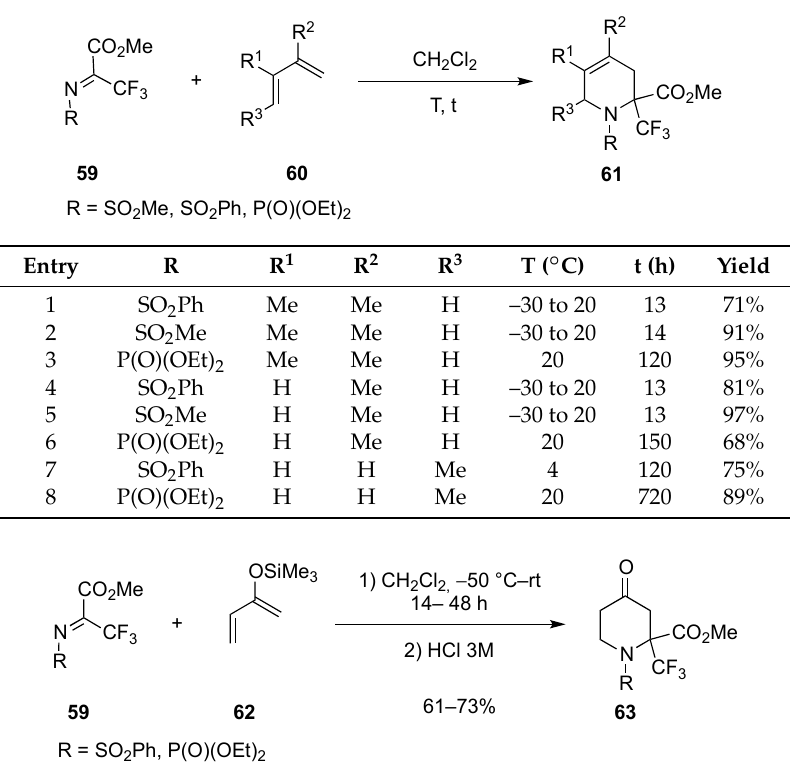
Table 1. Aza Diels-Alder cycloadditions.